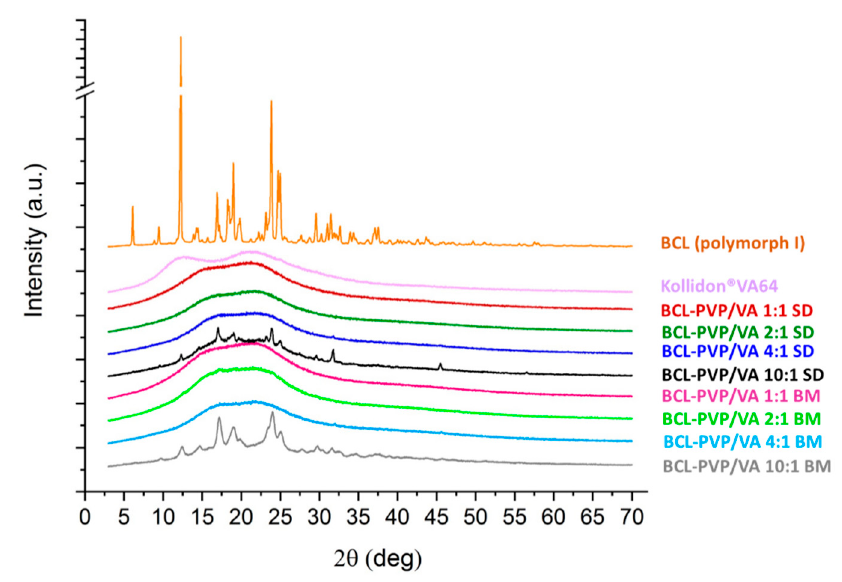
Figure 6. X-ray di ff raction patterns of crystalline BCL and Kollidon ® VA64 and BCL-PVP / VA solid Figure 6. X-ray diffraction patterns of crystalline BCL and Kollidon ® VA64 and BCL-PVP/VA solid dispersions obtained by either spray drying (SD) or ball milling dispersions obtained by either spray drying (SD) or ball milling (BM).